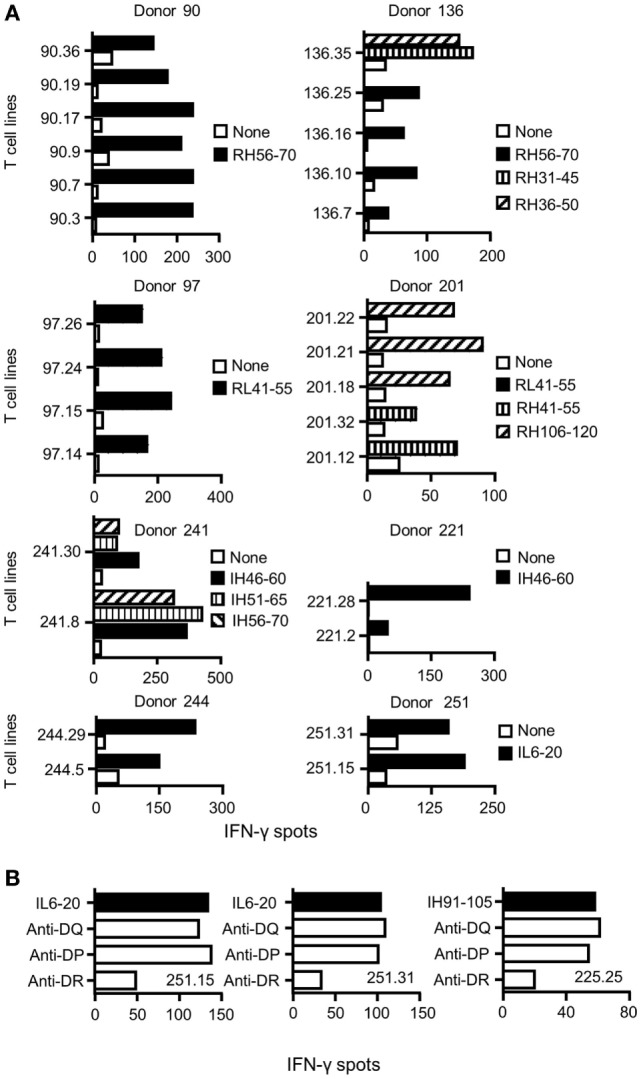
Specificity and restriction of T cell lines generated from healthy donors. (A) CD4 T cell lines were generated in vitro by four weekly rounds of stimulation with autologous dendritic cells loaded with either rituximab (Rtx) or infliximab (Ifx). T cells were incubated with autologous unloaded peripheral blood mononuclear cells (PBMCs) (none) and with PBMCs loaded with individual peptides. Activation of the T cells was evaluated by interferon-γ (IFN-γ) ELISPOT, and peptide specificity was confirmed in two independent experiments. Each panel reports the peptide-specific T cell lines found from one donor. Cells from donors 90, 97, 136, and 201 were used to evaluate the T cell response to Rtx, while cells from donors 221, 241, 244, and 251 were used for Ifx. (B) For inhibition assays, anti-HLA-DR (L243), -DQ (SPVL3), and -DP (B7/21) antibodies were added at 10 µg/mL to the IFN-γ ELISPOT.